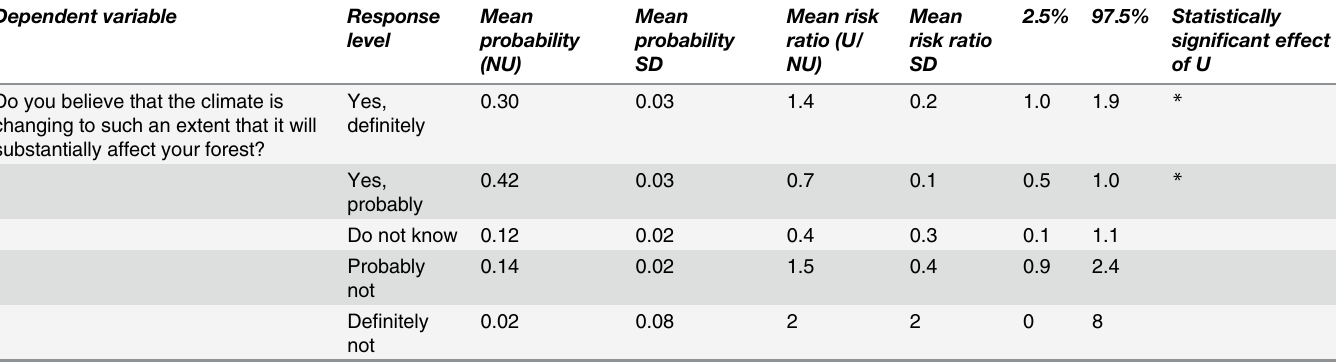
Table 5. Predicted probabilities for strengths of belief in the local effects of climate change based on no university education and relative risk ratios for strengths of belief in the local effects of climate change based on education level (have/have not university education) among German respondents (S6 Table).